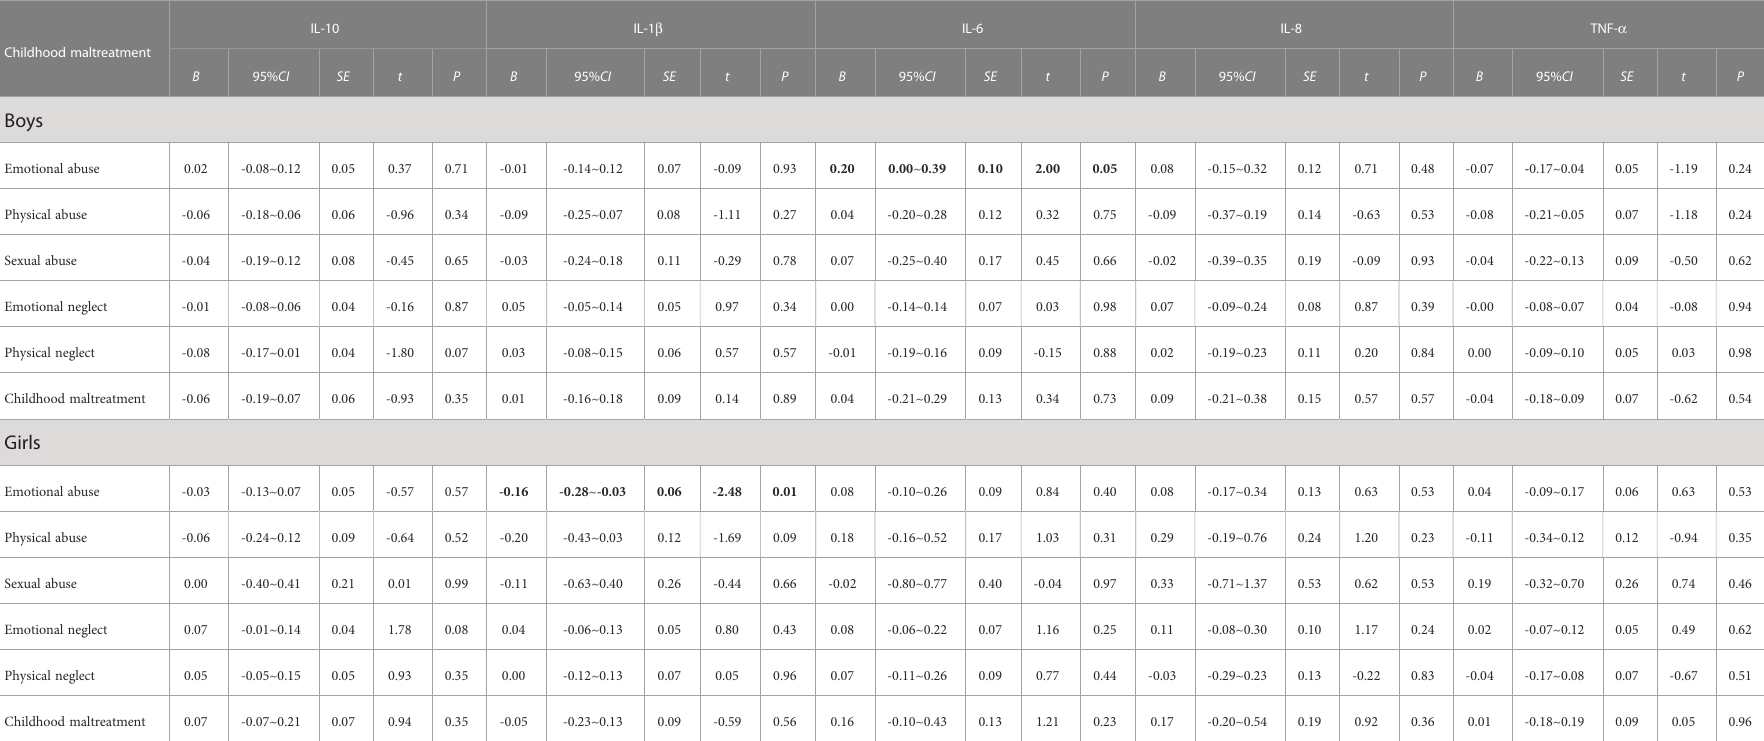
TABLE 4 Gender-speci fi c associations of childhood maltreatment with the levels of peripheral serum in fl ammatory cytokines.